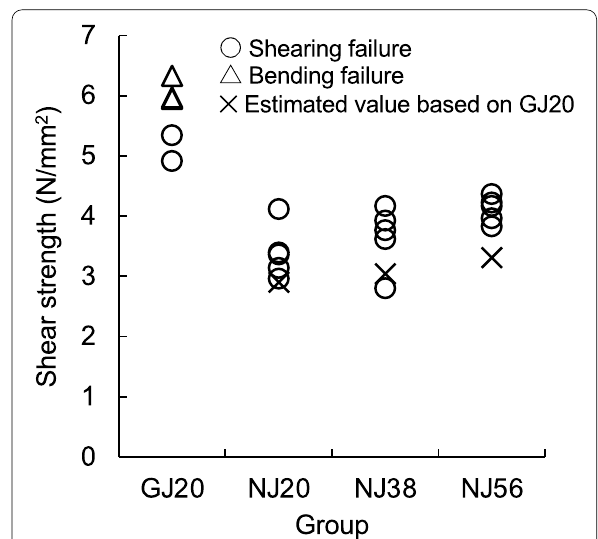
Fig. 7 Shear strength of each specimen using the asymmetric four-point bending